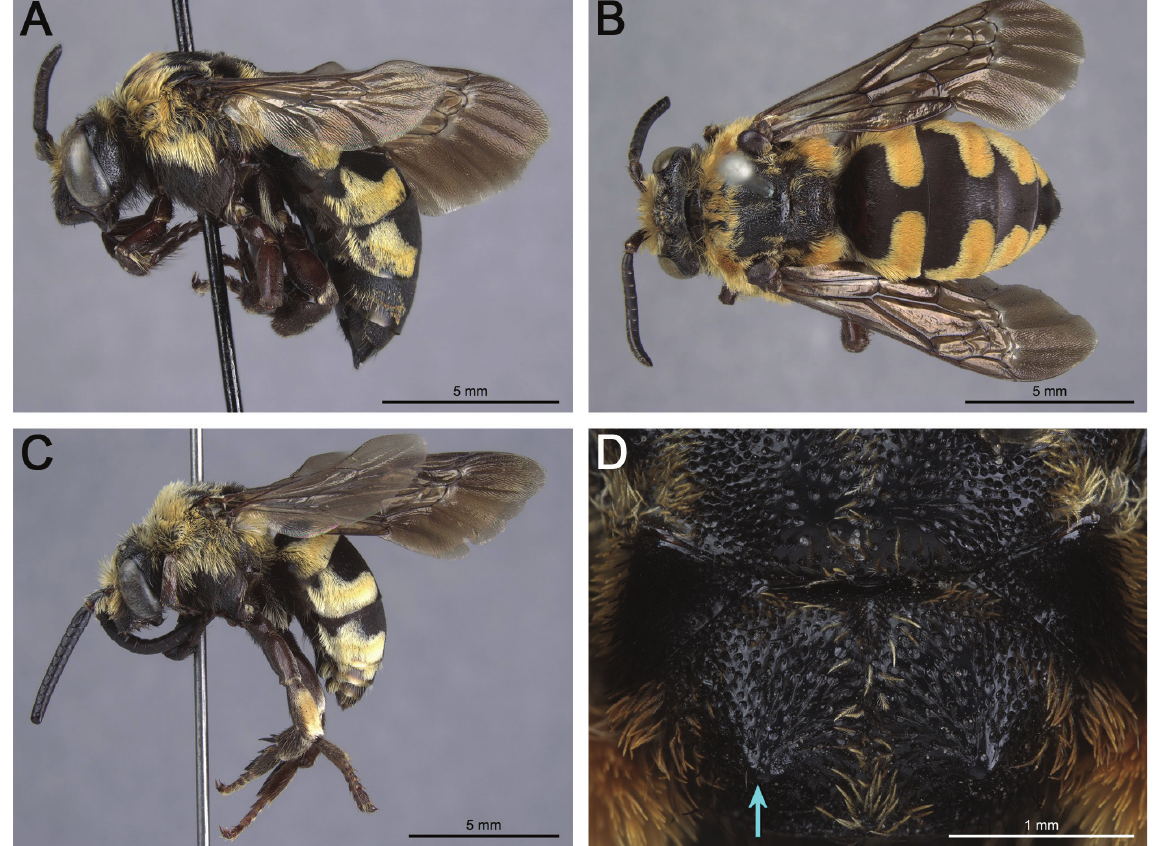
Fig. 13. Brachymelecta interrupta (Cresson, 1872). A . Female (CNC 891735), habitus, lateral view. B . Melecta interrupta lectotype, ♀ (ANSP 2291), habitus, dorsal view. C . Male (CNC 891719), habitus, lateral view. D . Female (BOLD sample ID: 14511H06-AZ; PCYU 0003840), axillae and mesoscutellum, dorsal view (blue arrow indicates one of two short, mammiform tubercles of